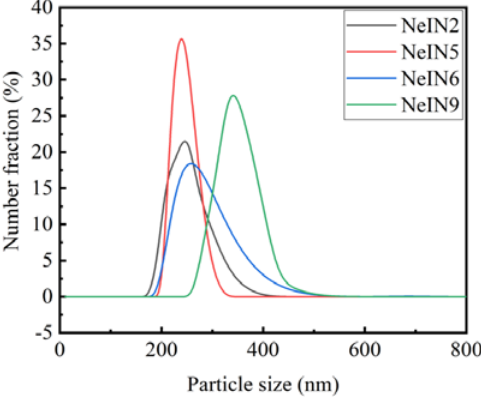
Figure 9. Particle size distribution of the nanocapsules.